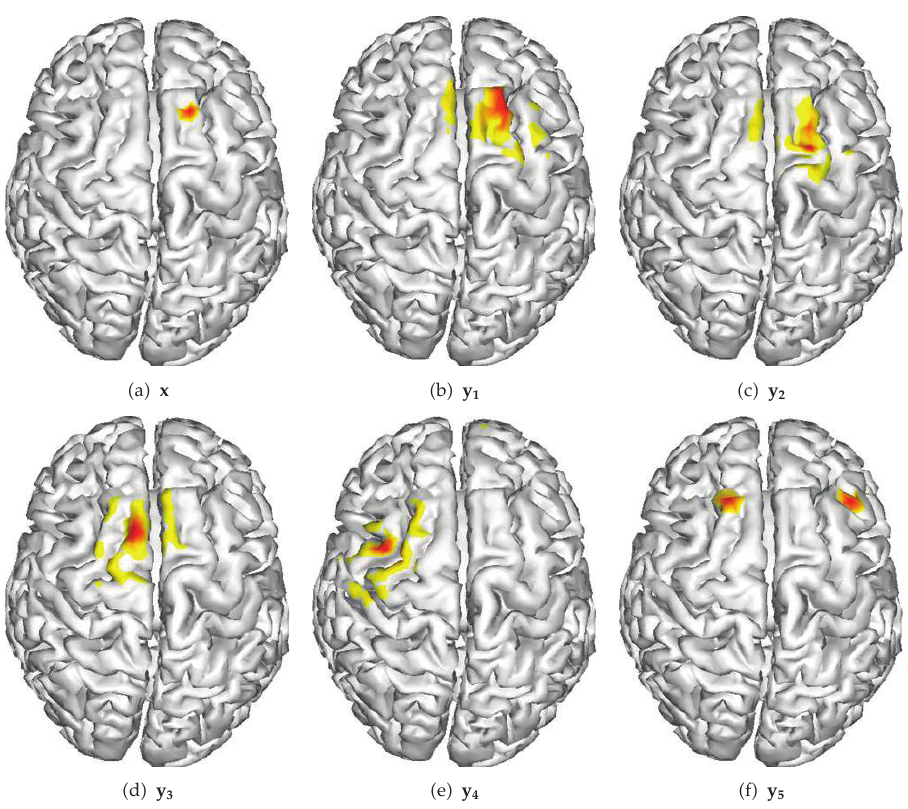
Figure 4: Simulation of three-dimensional cortical sources: actual source (cid:2) a (cid:3) and reconstructed sources (cid:2) b (cid:3) – (cid:2) f (cid:3)